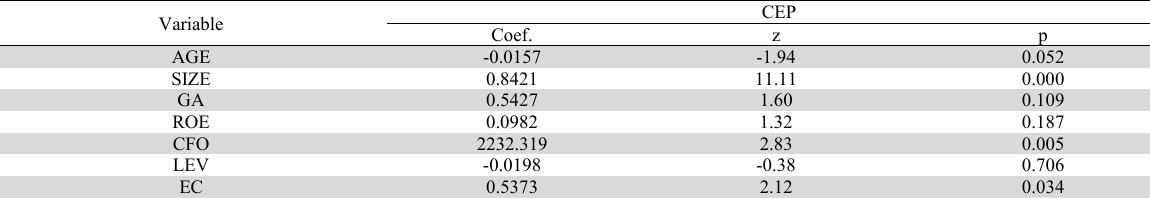
Hyphothesis 2 test result